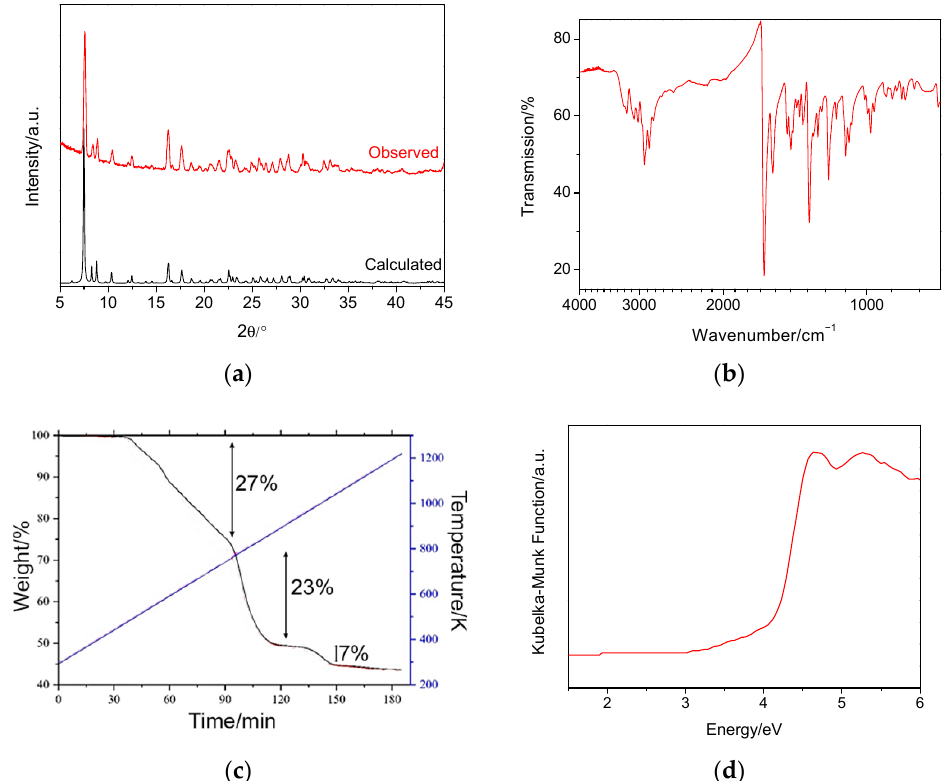
Figure 2. ( a ) Powder X-ray diffraction data collected for ground crystals of [C 9 H 17 N 2 ] 6 [Ga 10 S 16 (SH) 4 ]. ( b ) FT-IR data. ( c ) Thermogravimetric analysis data, collected under air. The temperature is given by the blue line. ( d ) UV–Vis diffuse reflectance data.